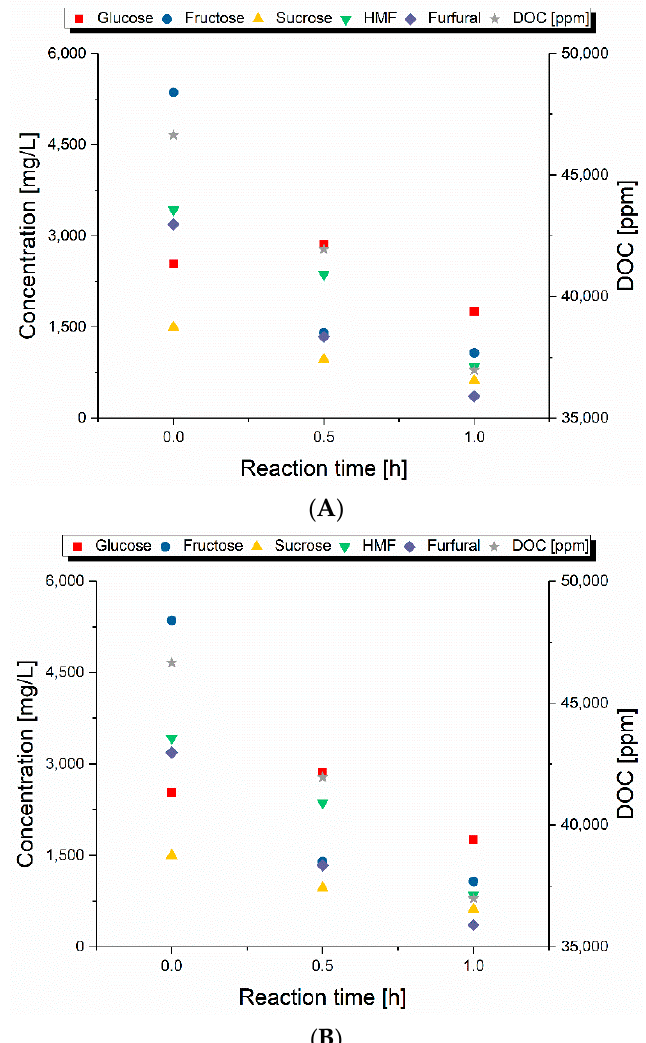
Figure 5. ( A ) Concentration of the sugars, HMF and furfural as well as dissolved organic carbon (DOC); ( B ) concentration of the acids in the process liquid and their pH after HT at 200 °C for different reaction times.